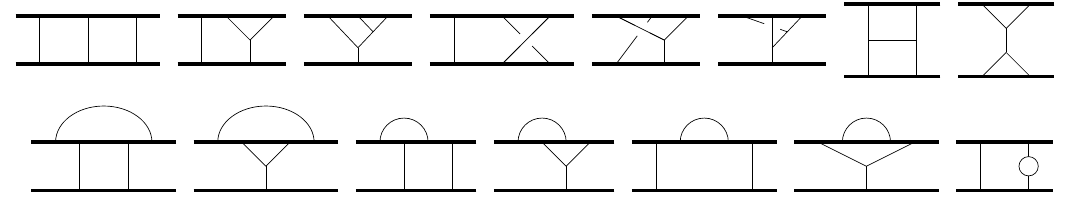
Figure 5. Cubic diagrams relevant for the classical O ( G 3 ) impulse and radiated momentum in general relativity (including radiative